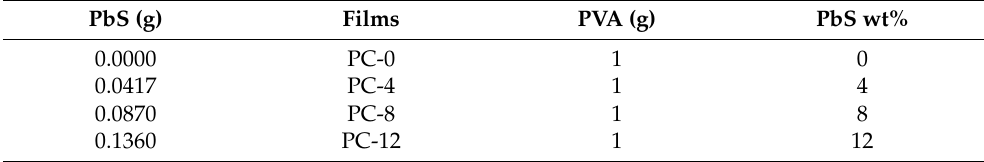
Table 1. Chemical elements of